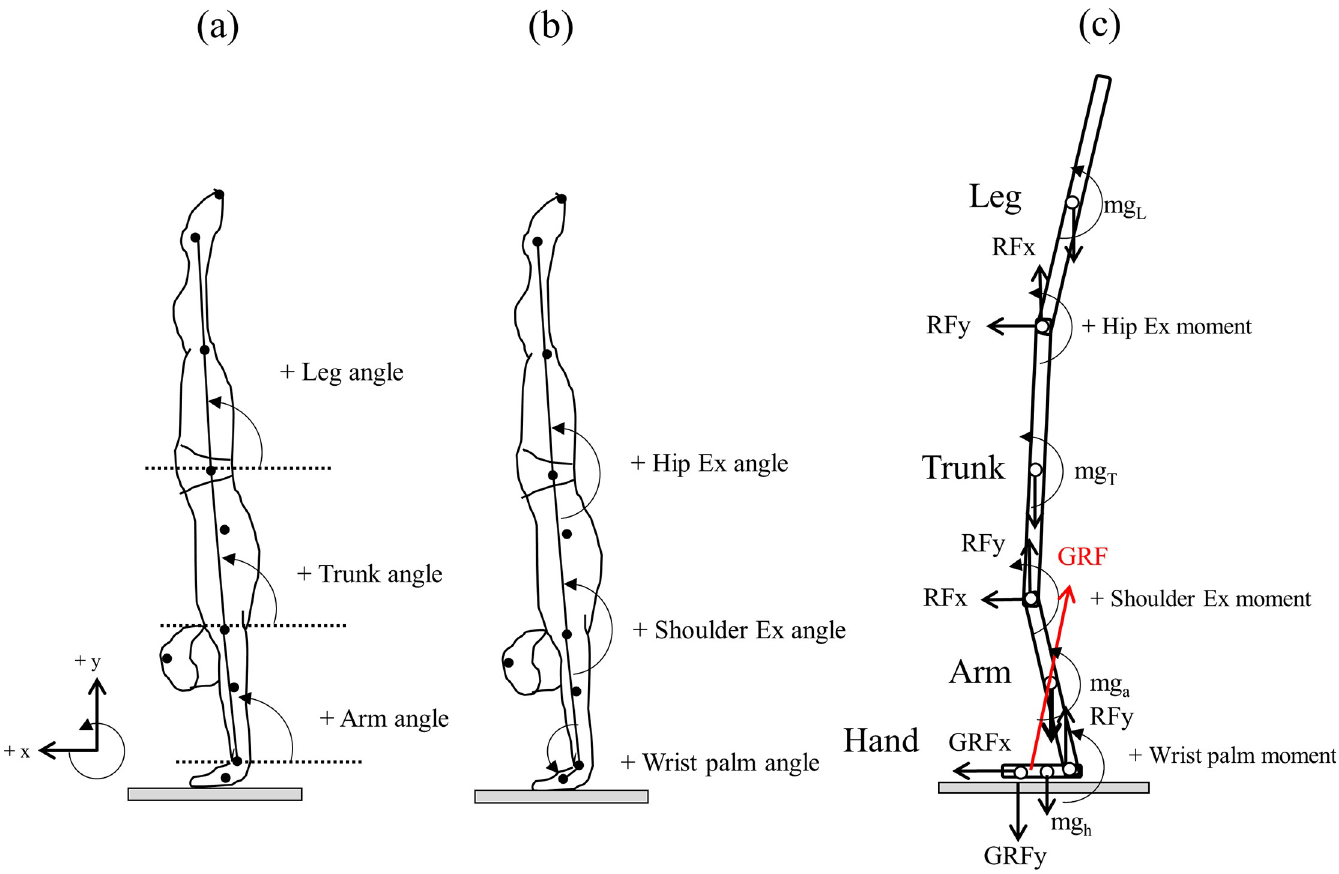
Fig 2. Definitions of kinematics and joints moment for inverse solution inputs in four segment model. Segments angles (a), joints angles (b) and joint reaction forces as well as moments around segment mass (c). Counterclockwise directions in segment angles and extensors in joint angles and moments assumes as plus sign,